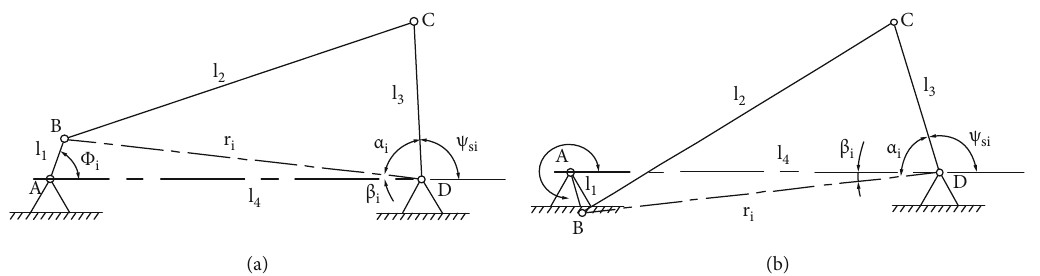
Figure 23: Di ff erent ranges of crank input angle correspond to rocker output angle.